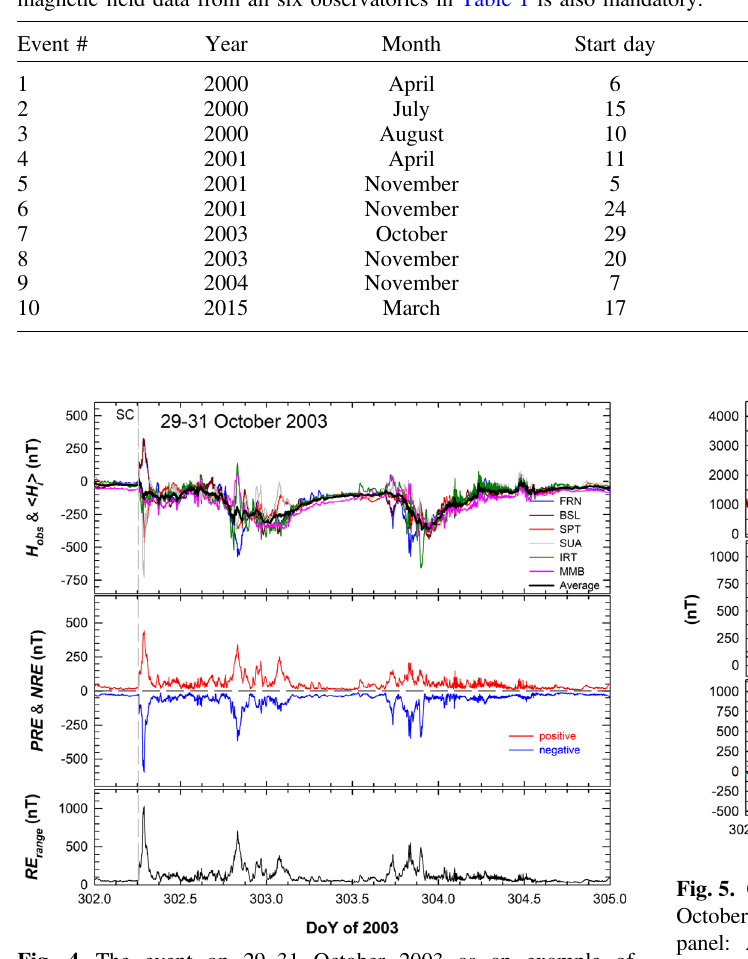
Fig. 4. The event on 29 – 31 October 2003 as an example of processing. Top panel: Magnetic disturbance, H obs , at the mid- latitude observatories in Table 1 (in colours) and the average of the disturbance h H i i (in black); Second panel: Positive (red) and Negative (blue) Residual Envelopes; Bottom panel: Residual Envelopes range as a proxy for the asymmetry intensity. Grey dashed line marks the SSC in the period plotted.